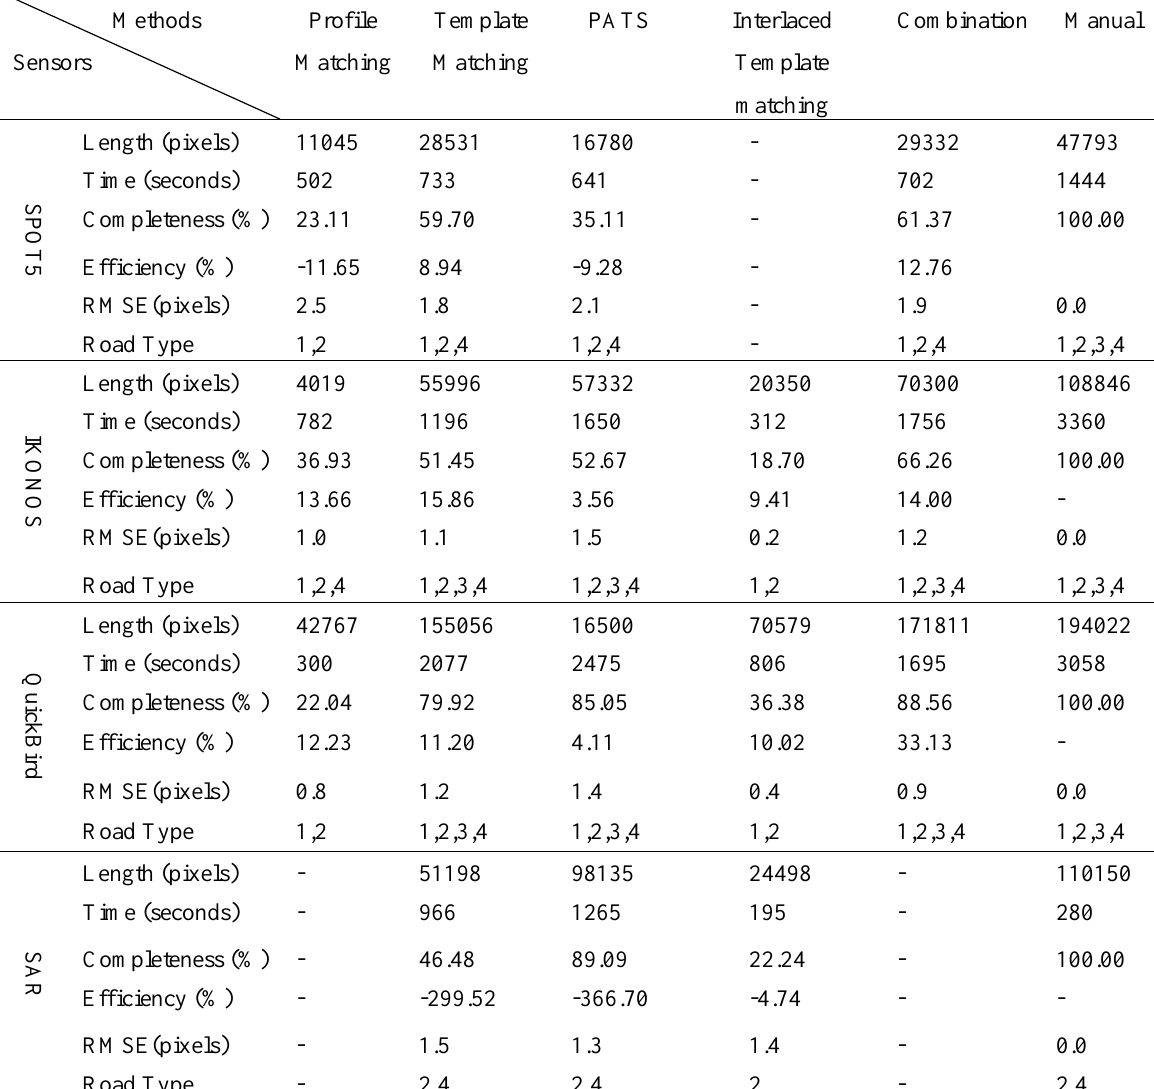
Table 2. Statistics about the performance of the